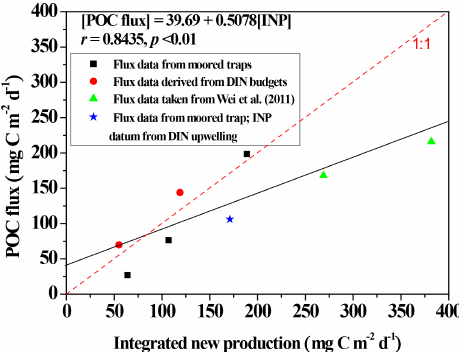
Figure 9. Scatter plots depicting the relationship between integrated new production (INP) and POC fluxes through a depth of 100m at the SEATS station, except for a datum (star symbol) derived from the station near the Dongsha Atoll (Hung et al., 2021). INP data were adapted from Y.-L. Chen et al. (2007, 2008, 2014) except for a datum derived from Hung et al. (2021). Data of POC fluxes through 100–120m were derived from the moored trap (Tsai, 2007; Hung et al., 2021) and floating traps (Wei et al., 2011), except for two data items derived from DIN budgets (Hung et al., 2007). The solid black line denotes the linear regression ( r = 0.8435, p < 0.01, n = 8) be- tween INP and POC fluxes for all presented data.